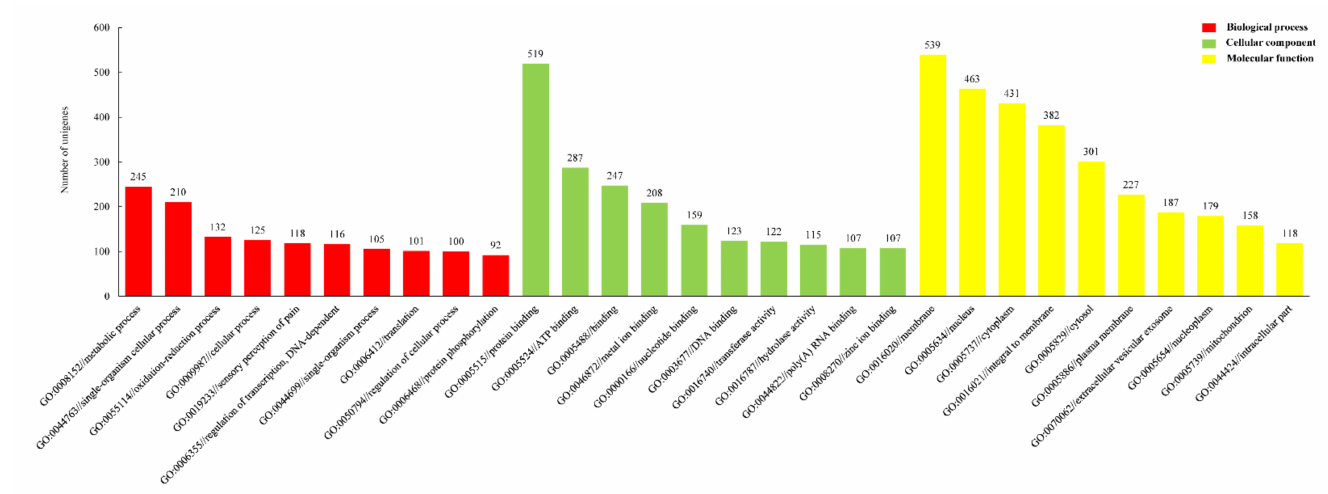
Figure 8. Gene ontology (GO) enrichment of new unigenes with >98% identity between two libraries of PS and CF. PS represents Portunus sanguinolentus and CF represents Charybdis feriatus